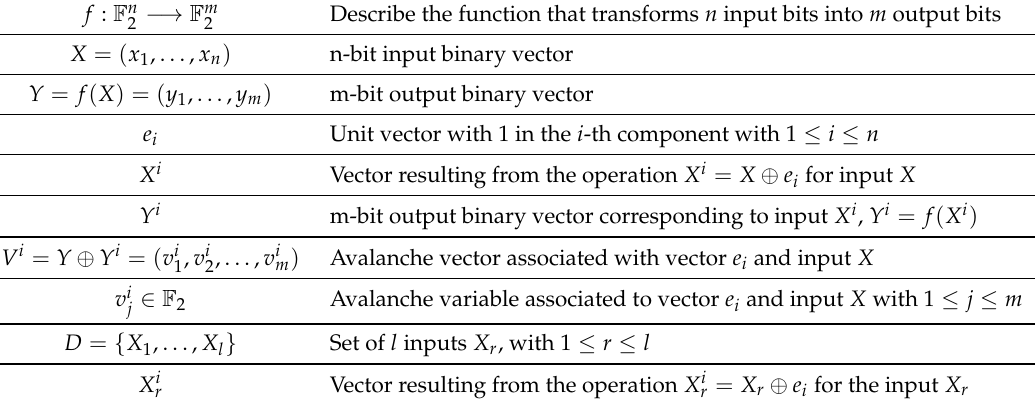
Table A1. Notation